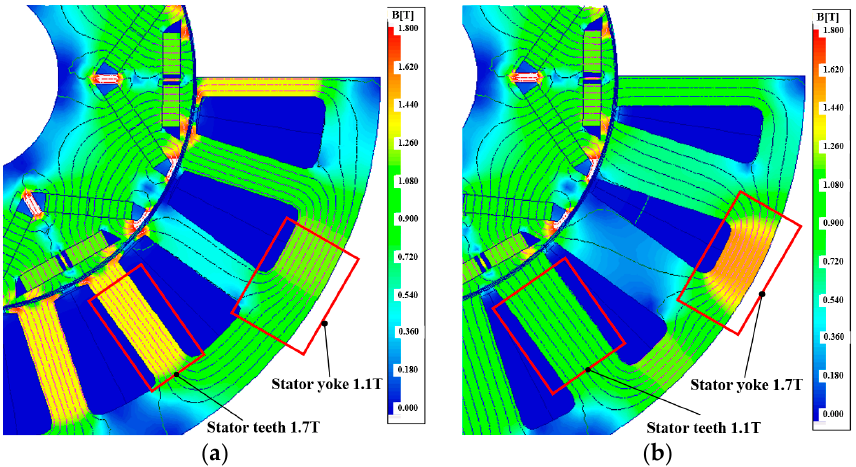
Figure 15. Stator flux density distribution in different stator tooth widths: ( a ) tooth width of 11 mm, and ( b ) tooth width of 20 mm.